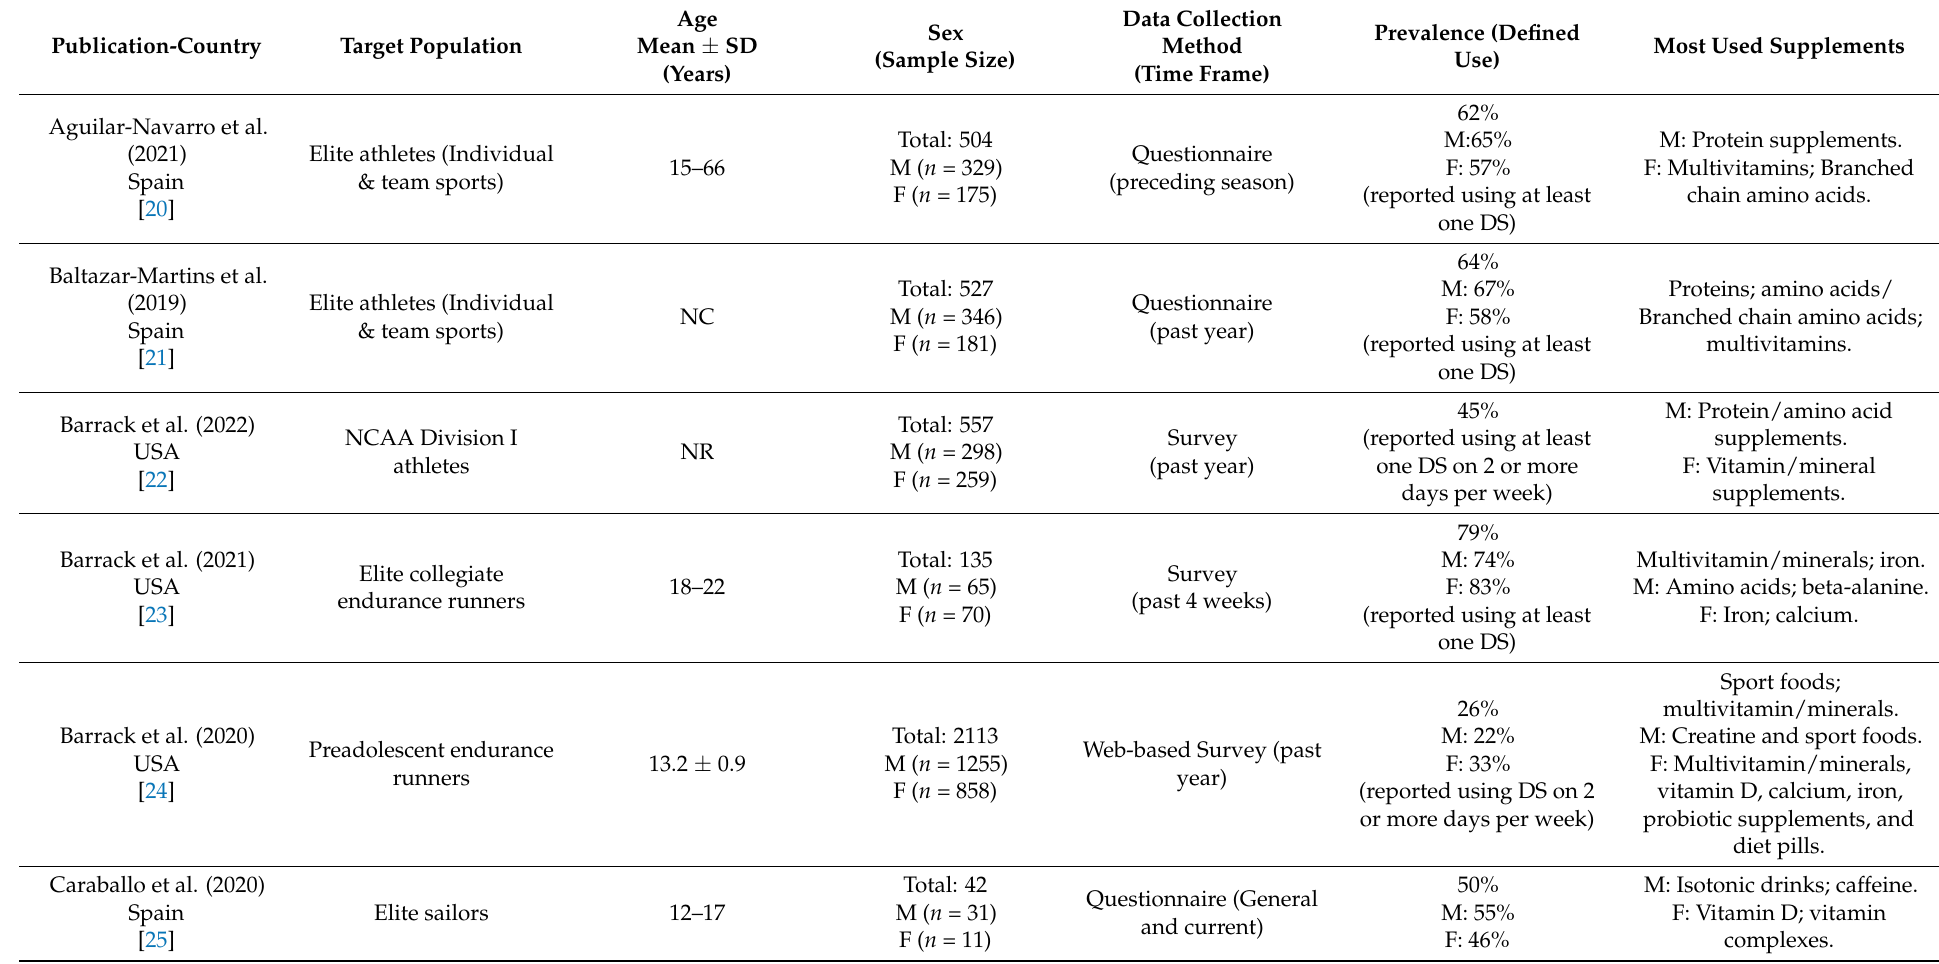
Table 1. Summary of studies with prevalence and most used dietary